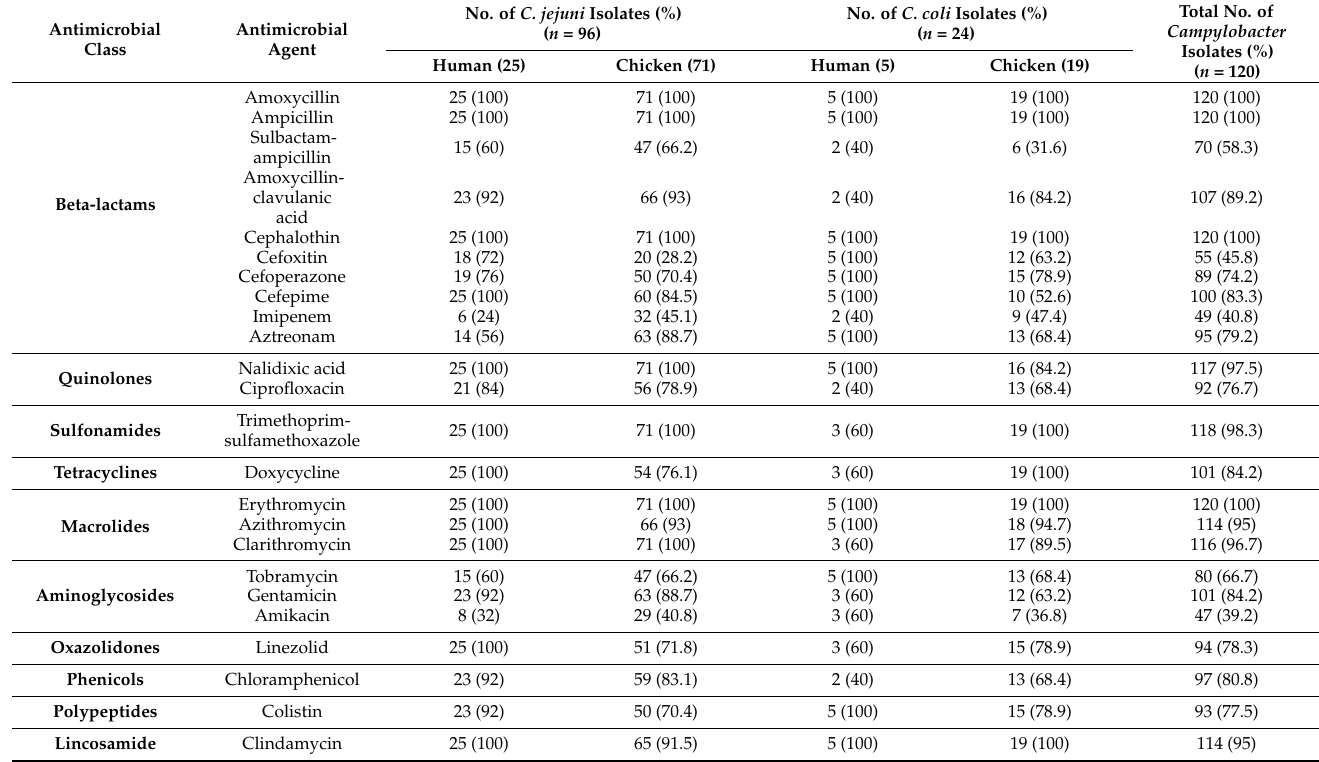
No. of C. coli Isolates (%) ( n = 24)